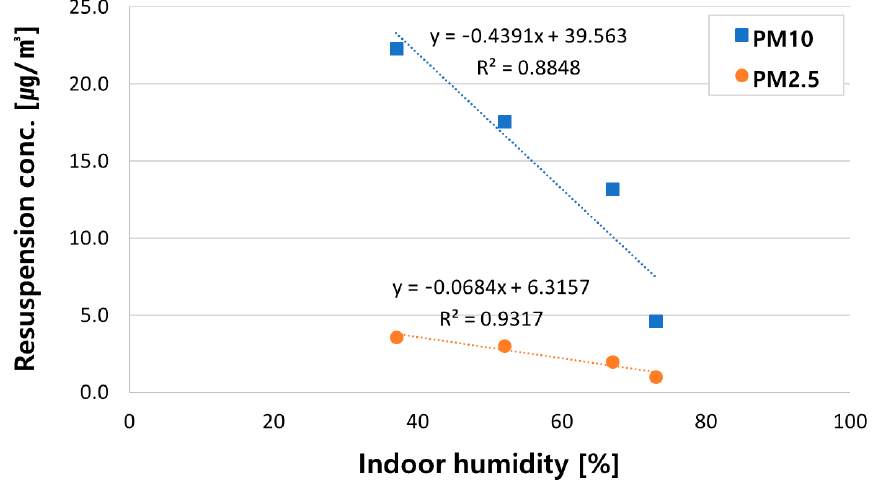
Figure 7. Comparison of PM resuspension concentration under each humidity condition.